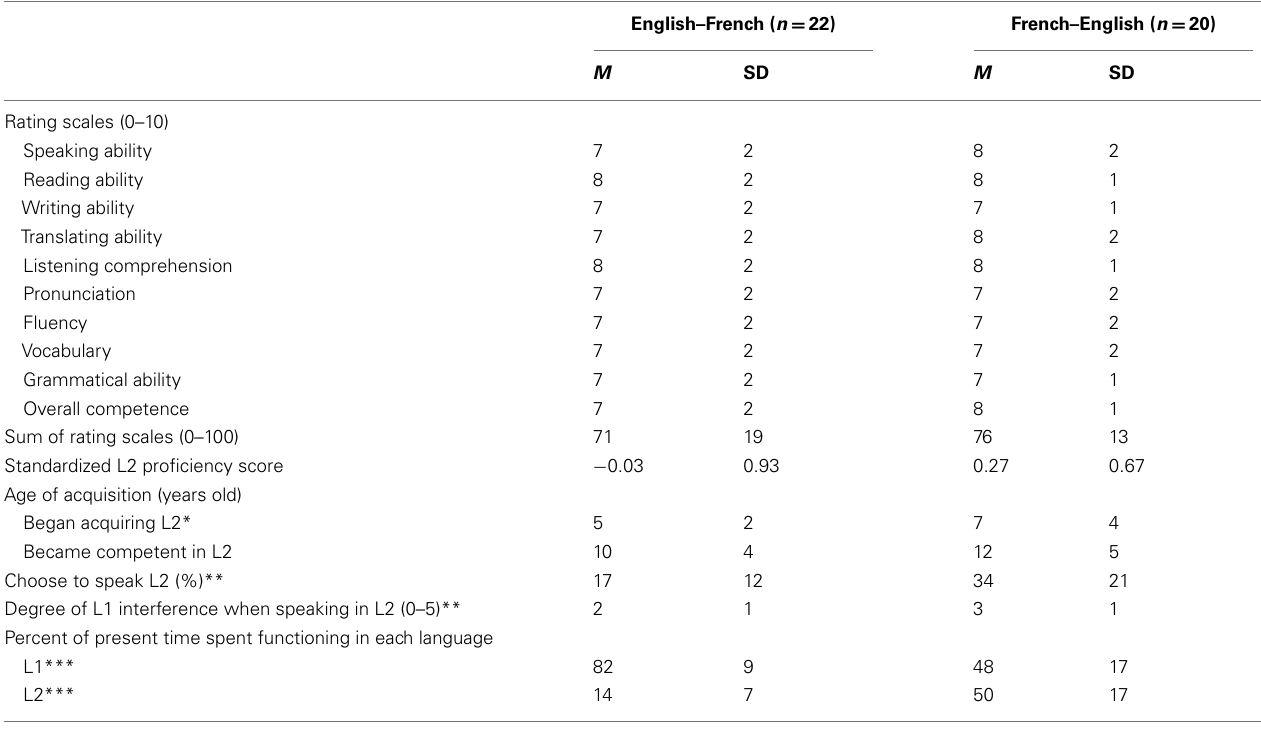
Table 1 | Self-assessed L2 proficiency ratings, language history, and standardized L2 proficiency scores ( n =